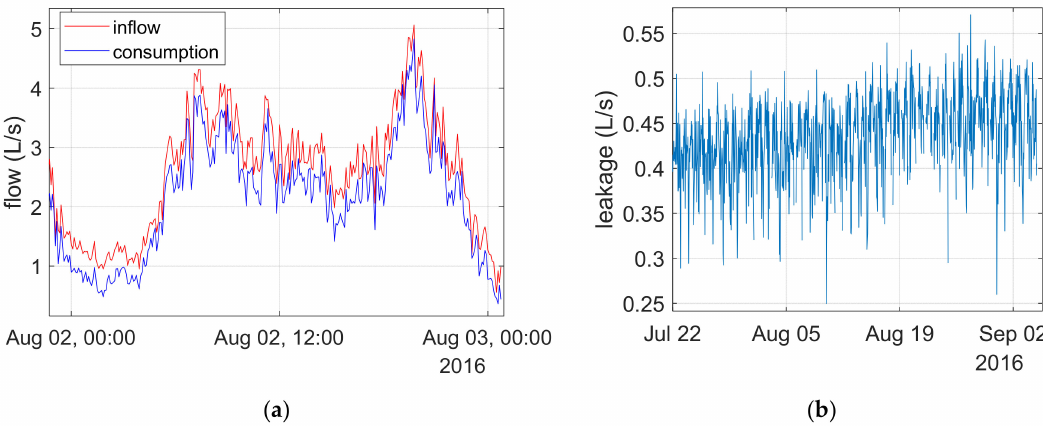
Figure 4. ( a ) District metered area (DMA) inflow ( red ) and the sum of all the users’ water consumption ( blue ) with a 5 min time step over one day. ( b ) Trends in the leakage with a 60 min time step over the period of 45